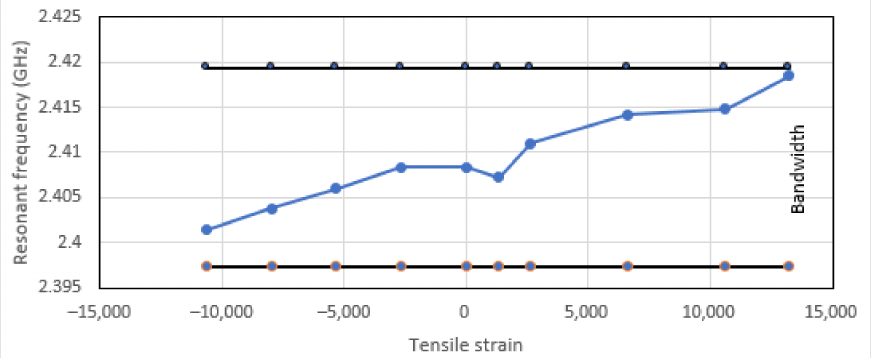
Figure 10. Resonant frequency excursions of the patch antenna which underwent tensile and com- pressive loading plotted against antenna bandwidth.